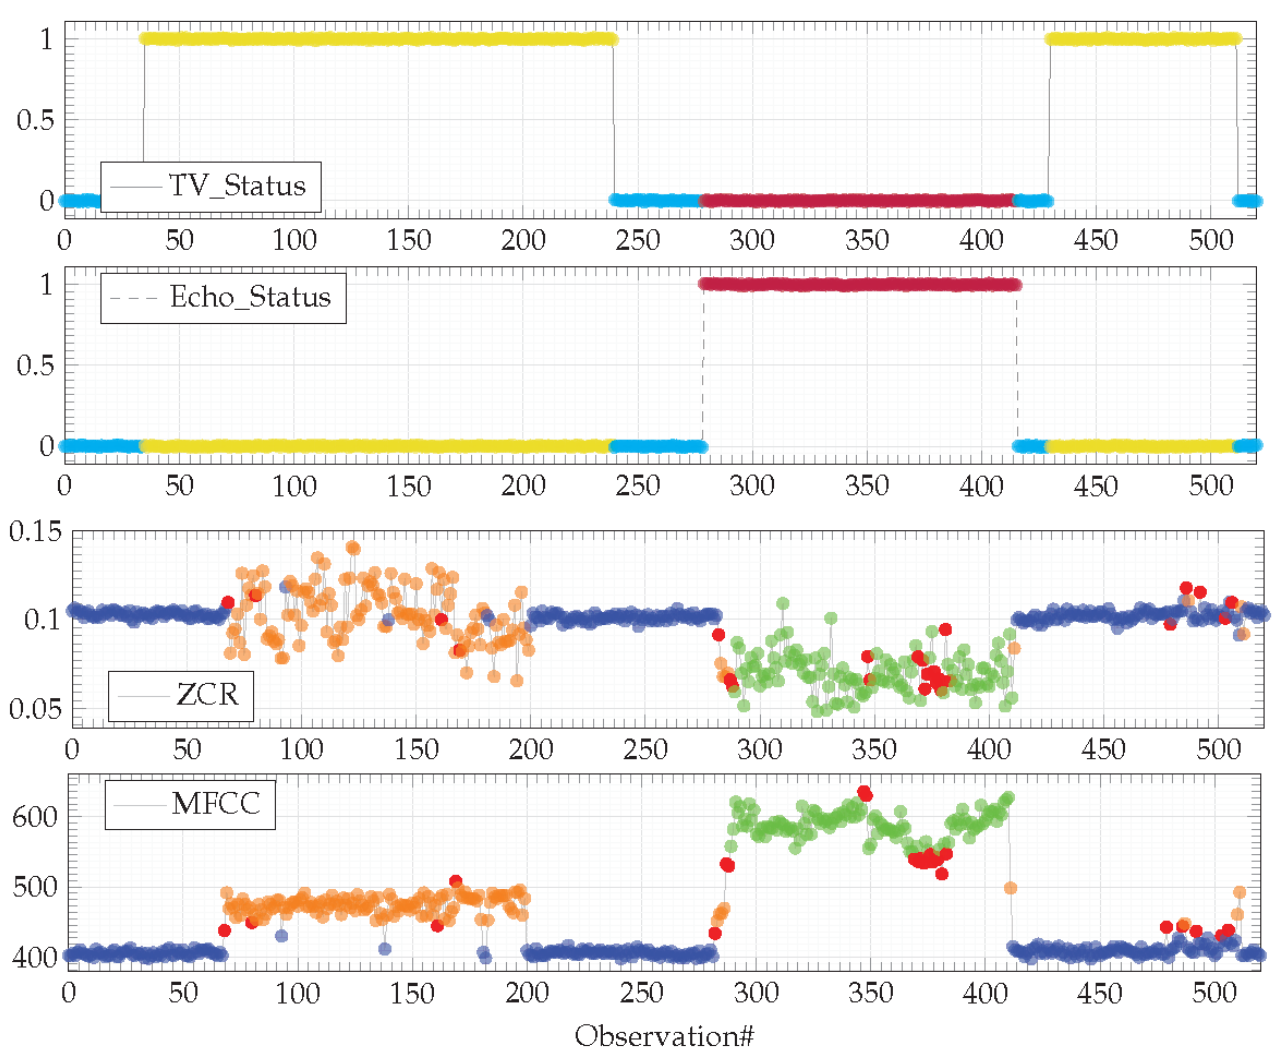
Figure 6. Real dataset representing the sound effects legitimately produced by two devices (TV and Amazon Echo smart speaker) in different contexts. Observations are colored according to the clusters identified by the HDBSCAN* algorithm with min_samples =